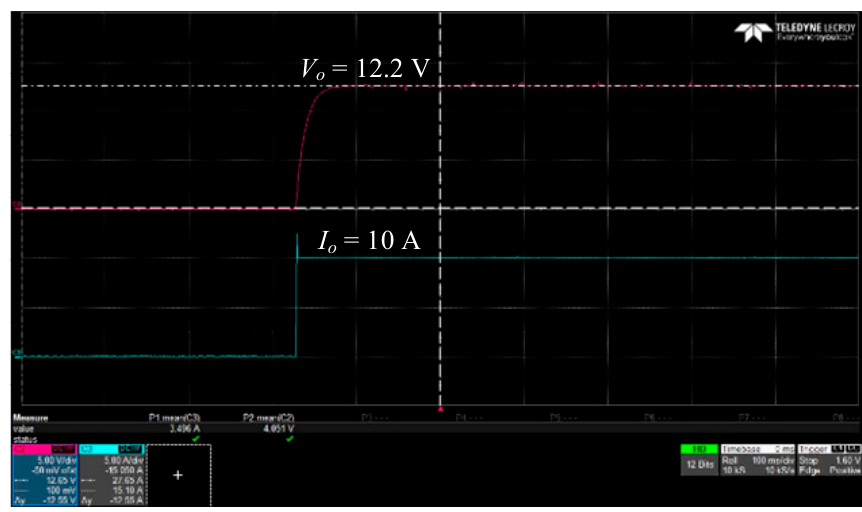
Figure 10. PWM signals of E-mode GaN HEMT. ( a ) No-load, 2 V/div, time: 1 μ s/div. ( b ) Full-load, 2 V/div, time: 1 μ s/div.